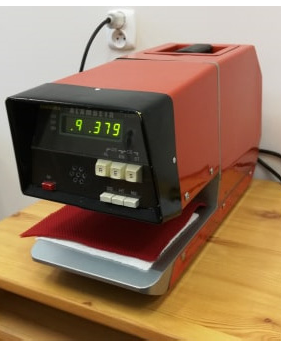
Figure 22. The double-plate Alambeta device.